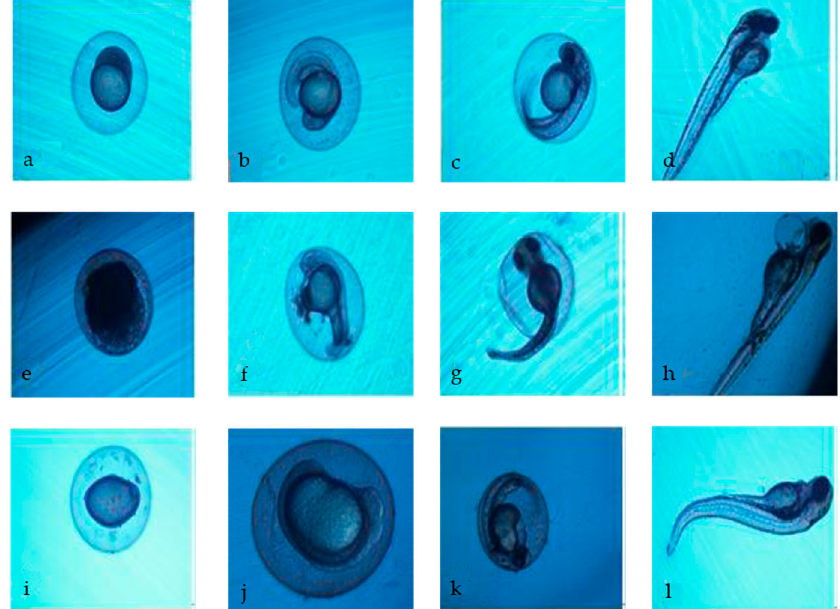
Figure 6. Effect on the early development of zebrafish embryos exposed to diluted landfill leachate. ( a – d ) normal development; ( e ) 6 h-coagulated egg; ( i ) 12 h-egg growing block; ( f ) 24 h-pericardial